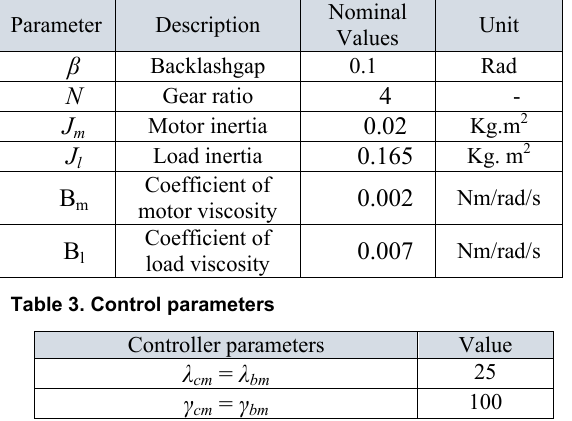
Table 4. Nominal and uncertainty parameters of the two- mass system Contact